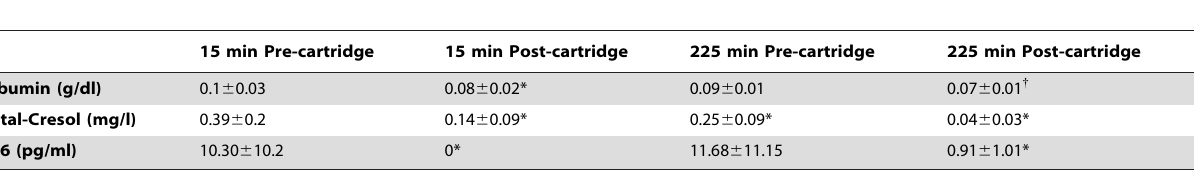
Table 2. Albumin, total-cresol and IL-6 concentrations in ultrafiltrate samples collected before and after the HFR sorbent cartridge at the beginning and at the end of the dialysis session.